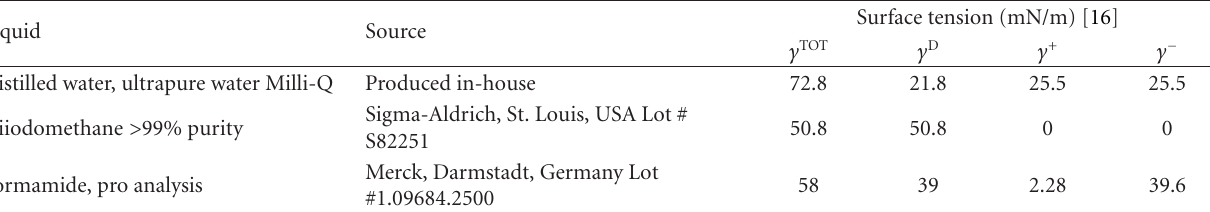
Table 2: Test liquids and their surface tension components.